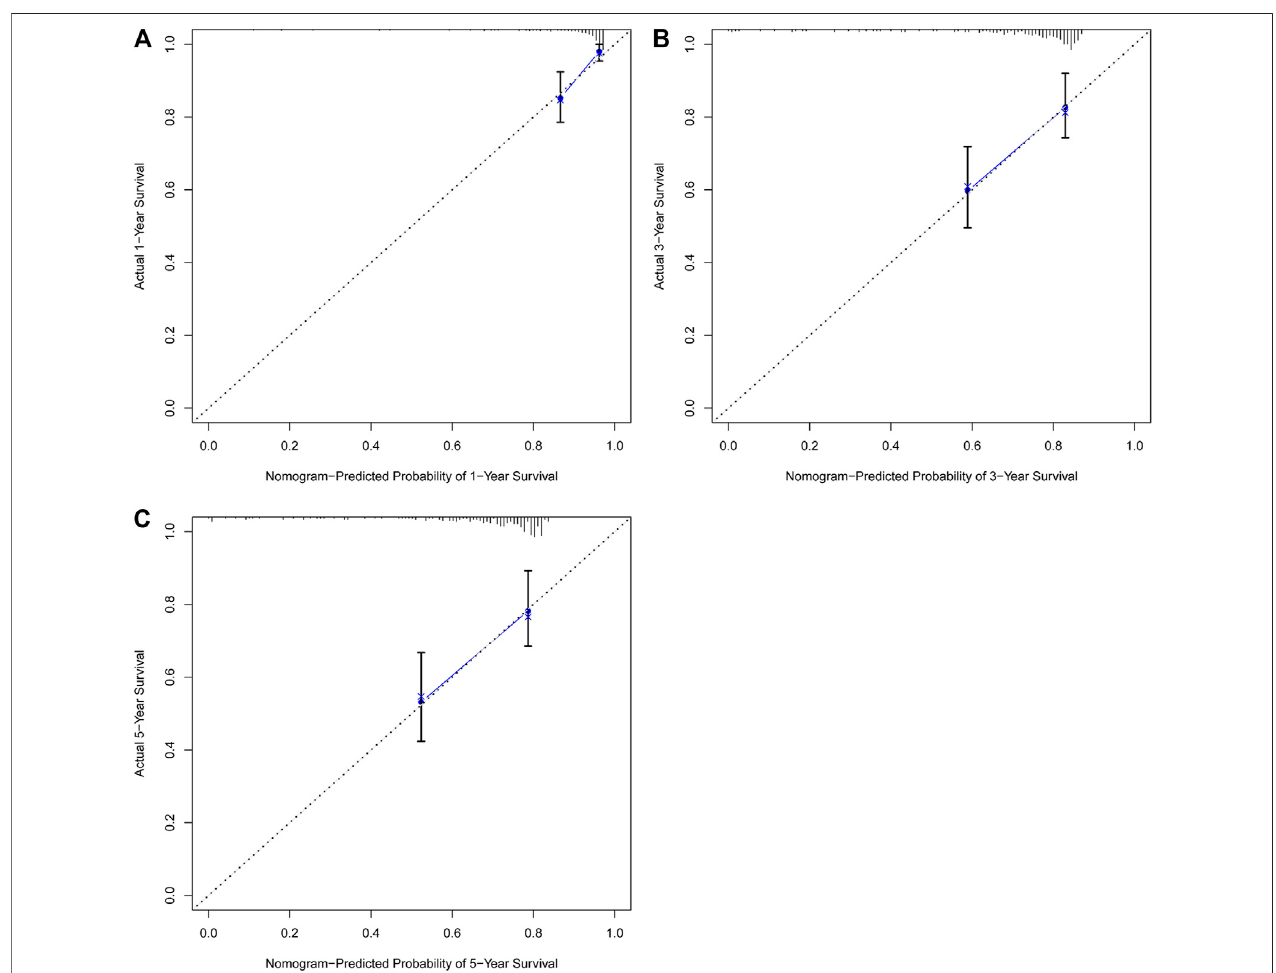
FIGURE 6 | The nomogram showed favorable agreement between nomogram-predicted OS probability and actual OS probability. Calibration plots for predicting (A) 1-year, (B) 3-years, and (C) 5-years OS for CSCC patients based on the nomogram. The 45-degree dotted line represents the “ ideal ” prediction. The blue line represents the performance of the nomogram. The blue line closer to the ideal prediction has a higher predictive accuracy of the nomogram.